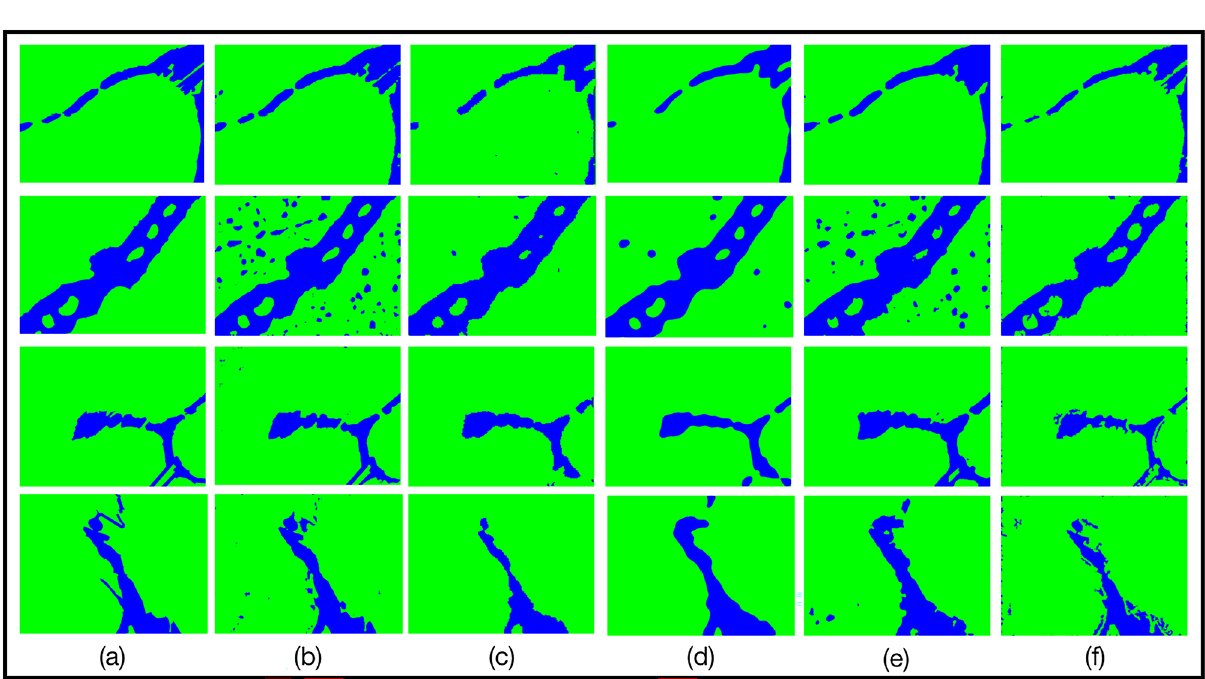
Figure 5. Comparison between the fully supervised deep learning methods and our CES method. ( a ) ground truth; ( b ) FCN method; ( c ) SegNet method; ( d ) PSPNet method; ( e ) Unet++ method; ( f ) CES (GBDT and post- processing